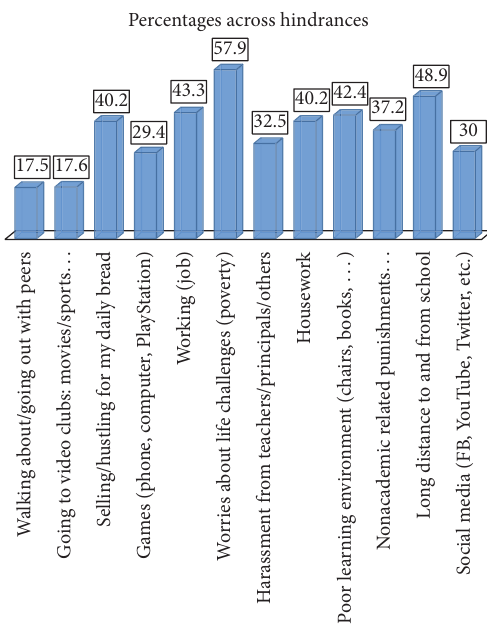
Figure 1: Learning hindrances identified by